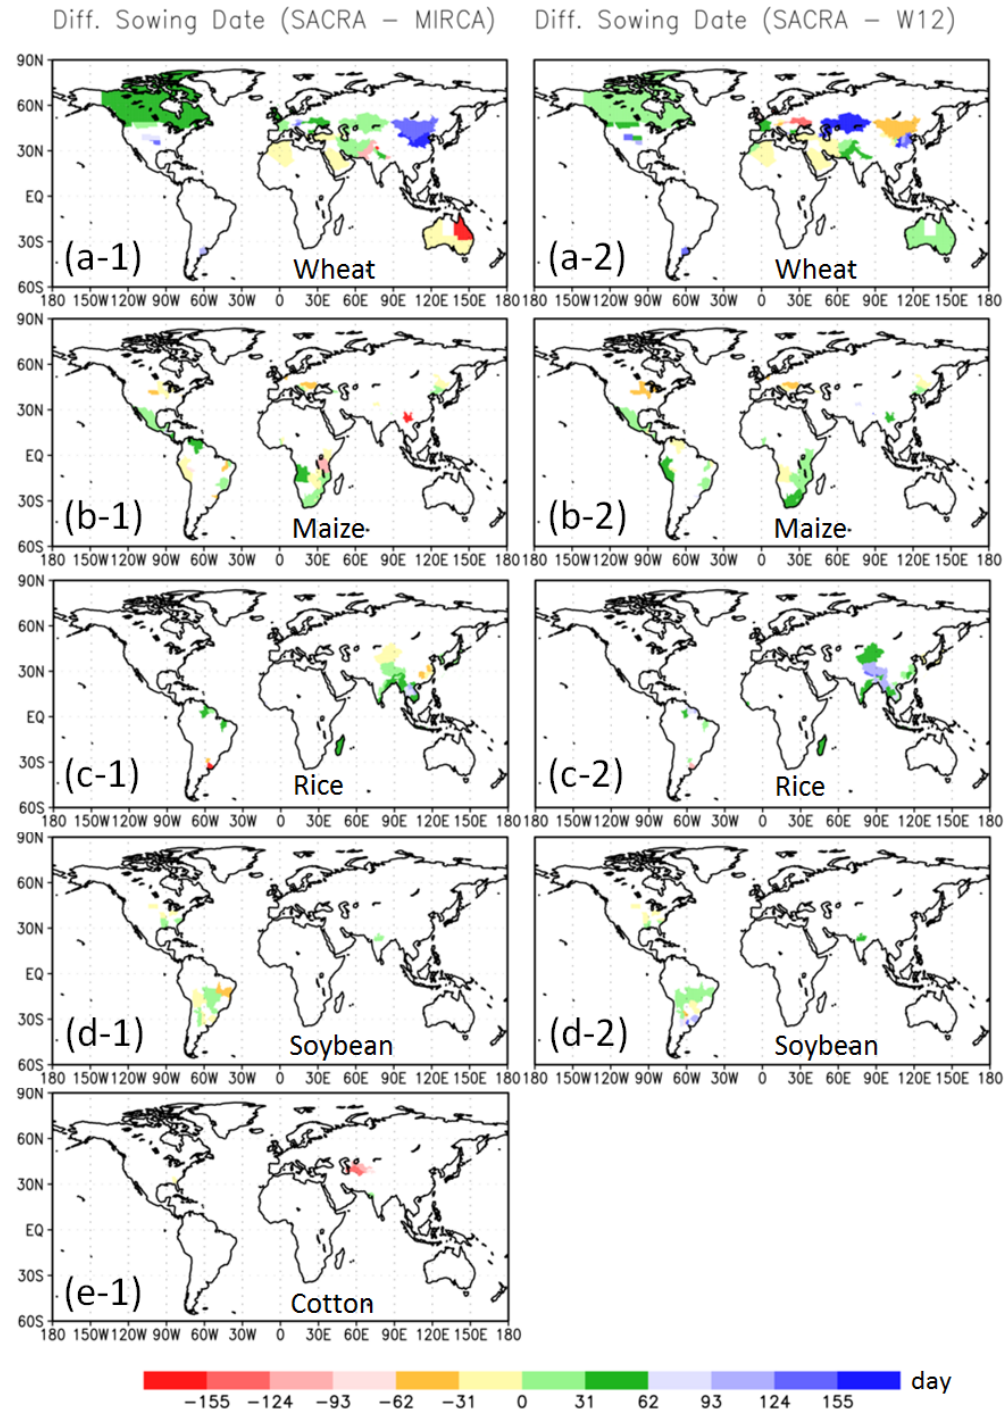
Figure A3. Same as Fig. 9 but for five specific crops (wheat, maize, rice, soybean, and cotton). The sowing date of cotton was not estimated by Waha et al. (2012). Only single cropping grids are used to compute the averaged sowing date for